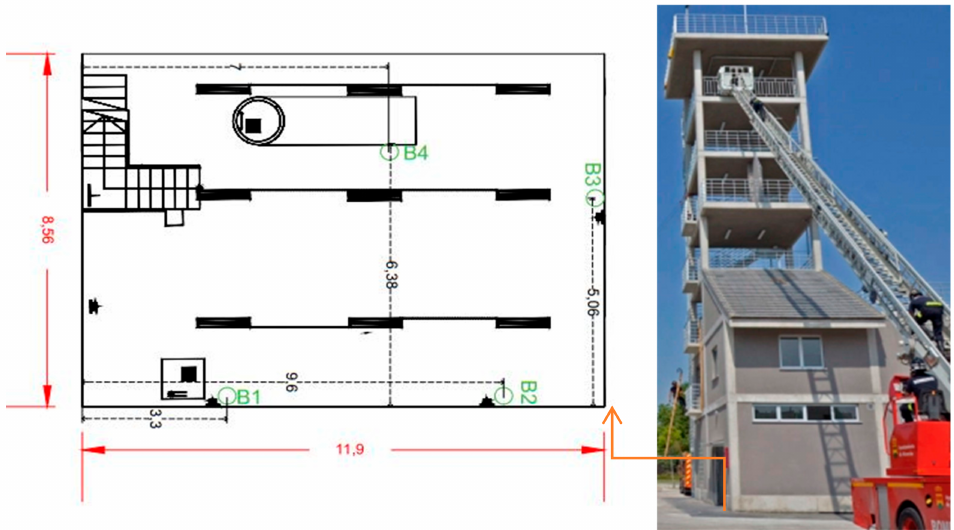
Figure 8. The confined space for the evaluation with the support of the USC-Alcorc ó